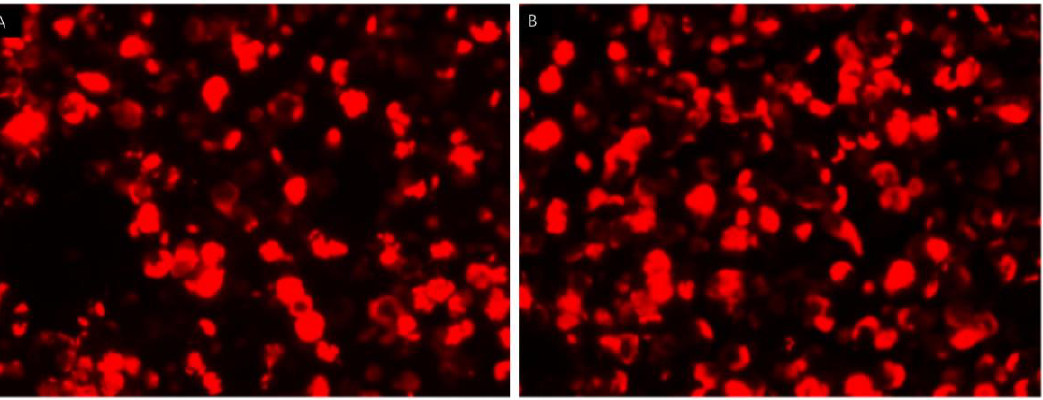
Figure 2. Indirect immunofluorescence assays of serum and cerebrospinal fluid (CSF). Cell-based assays of serum ( A ) and CSF ( B ) were both positive.